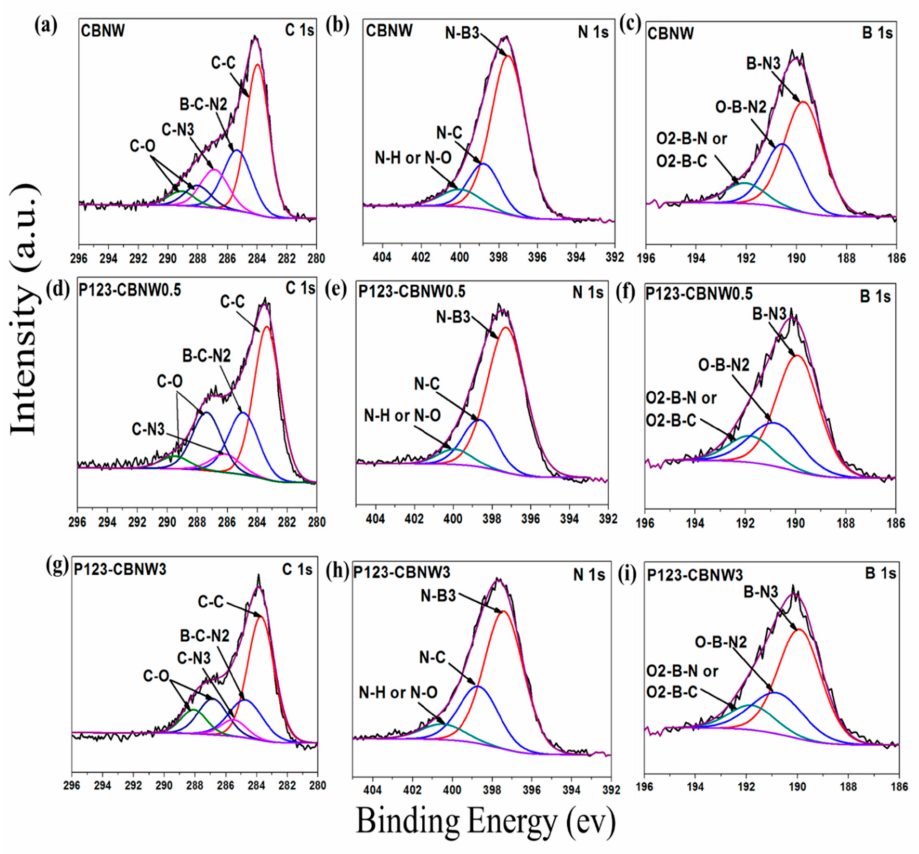
Figure 5. XPS scan of C1s ( a,d,g ), B1s ( b,e,h ), and N1s ( c,f,i ) of CBNW, P123-CBNW0.5 and P123-CBNW3